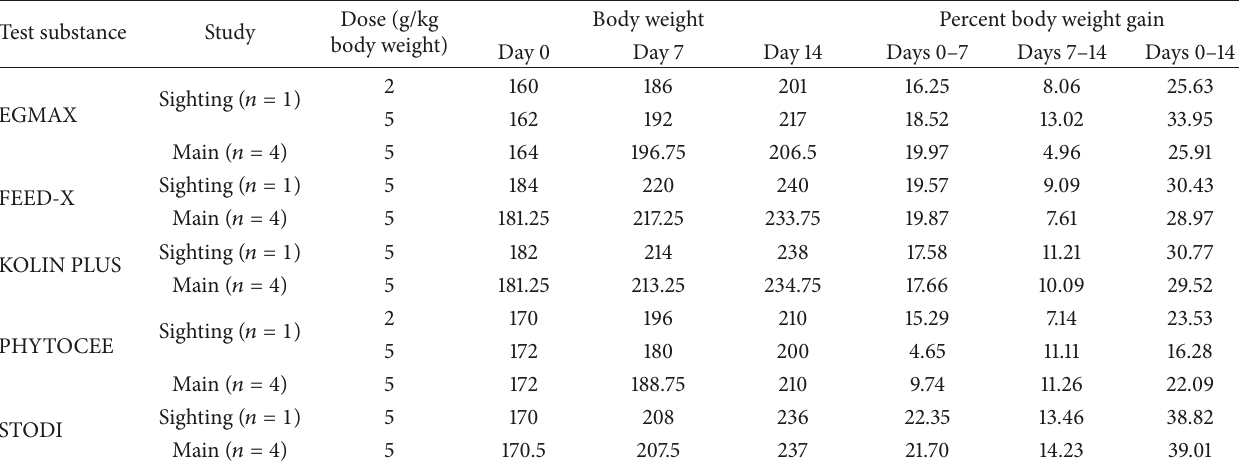
Table 8: Acute oral toxicity test results: effect of PFS on body weight and percent body weight